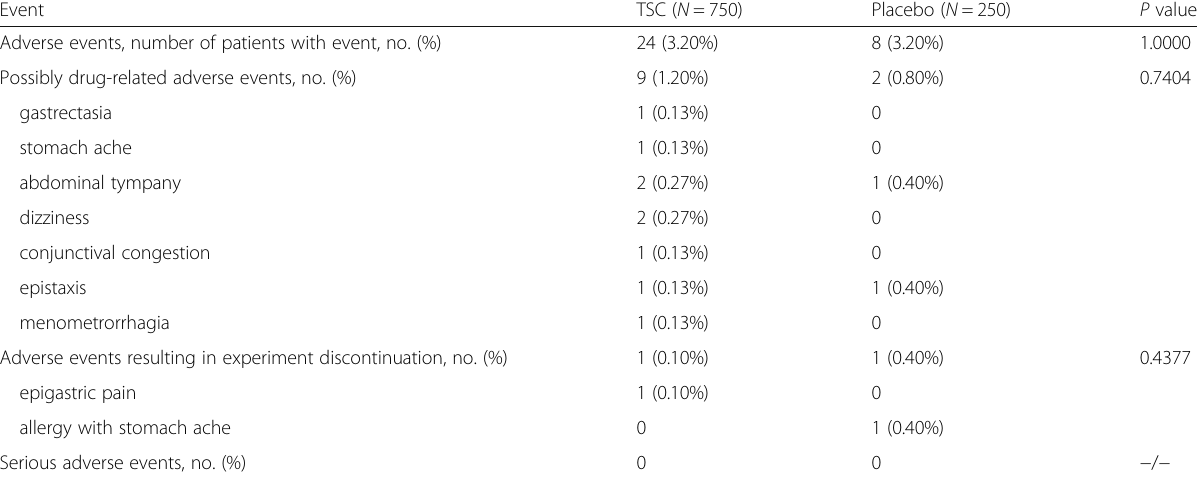
Table 6 Patients experiencing